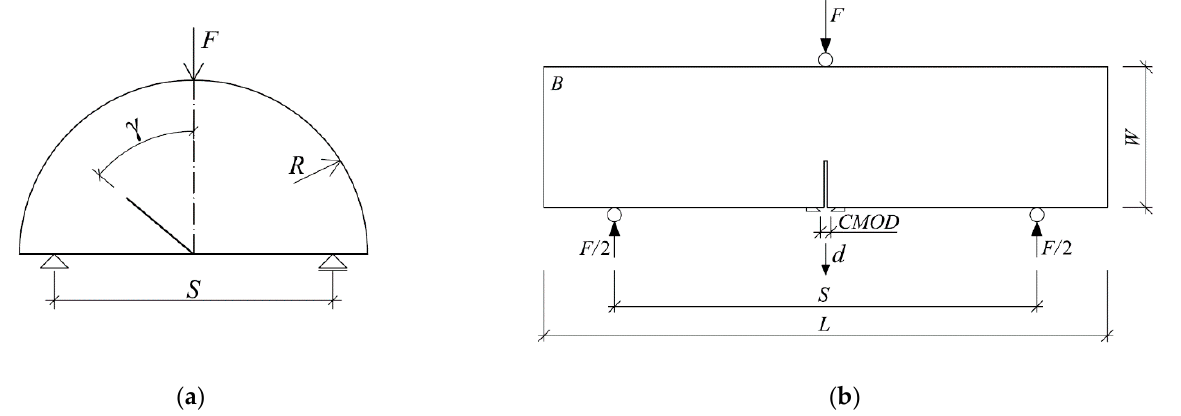
Figure 2. Three-point bending fracture test configuration of a selected semi-circular disc specimen with an inclined initial notch ( a ); and a beam specimen with a central edge notch ( b ).